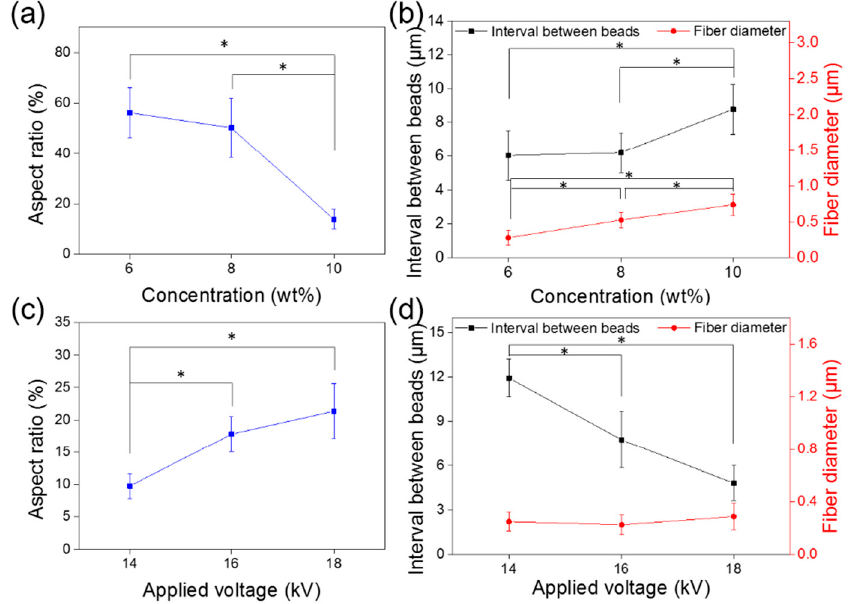
Figure 4. Effect of solution concentration on fiber properties: ( a ) bead AR; ( b ) inter-bead distance. Effect of applied voltage on fiber properties: ( c ) bead AR; ( d ) inter-bead distance. (* p < 0.05).